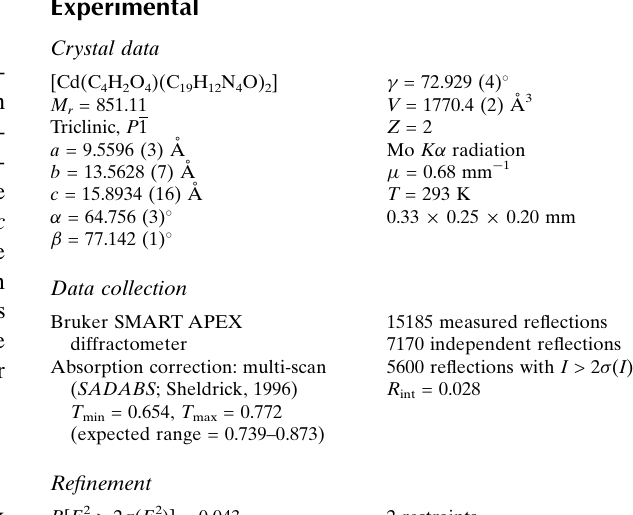
Key indicators: single-crystal X-ray study; T = 293 K; mean (cid:2) (C–C) = 0.006 A˚; disorder in main residue; R factor = 0.043; wR factor = 0.119; data-to-parameter ratio = 13.6. In polymeric title compound, [Cd(C